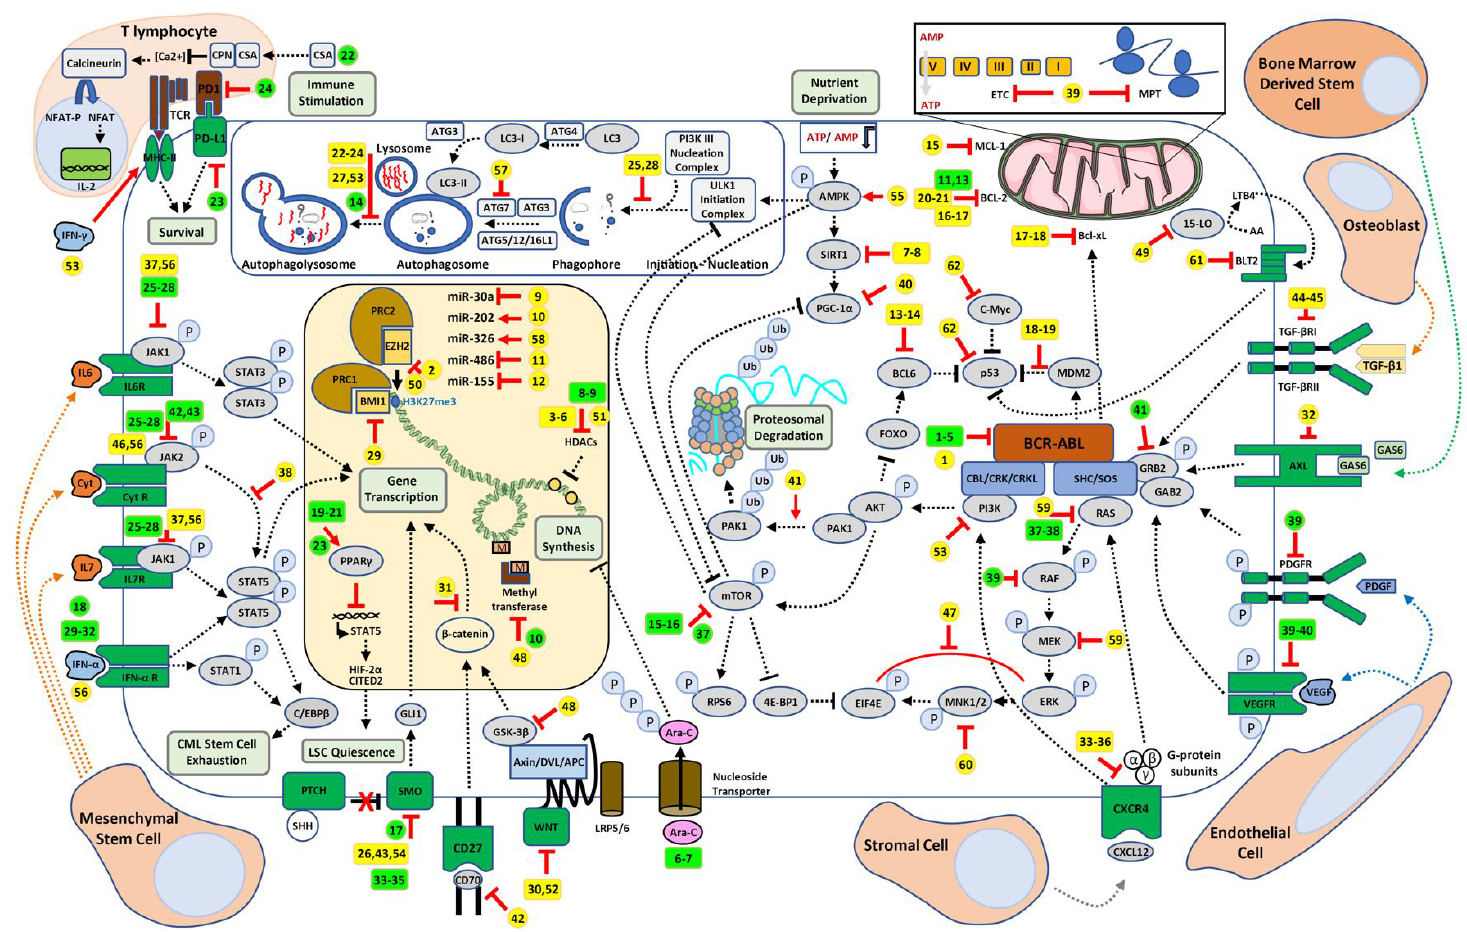
Figure 1. Chronic Myeloid Leukemia (CML) Leukemic Stem Cells (LSC) pathways involved in tyrosine kinase inhibitor (TKI) resistance and potential therapeutic targets to impair them. LSC (in the center) is represented within its microenvironment and key interactions with different bone-marrow cells are shown. This figure is coupled with Table 1 for ex-vivo candidate molecules (yellow tags) and Table 2 for clinical trials involving candidate molecules (green tags) with their respective mode of action (red symbols).